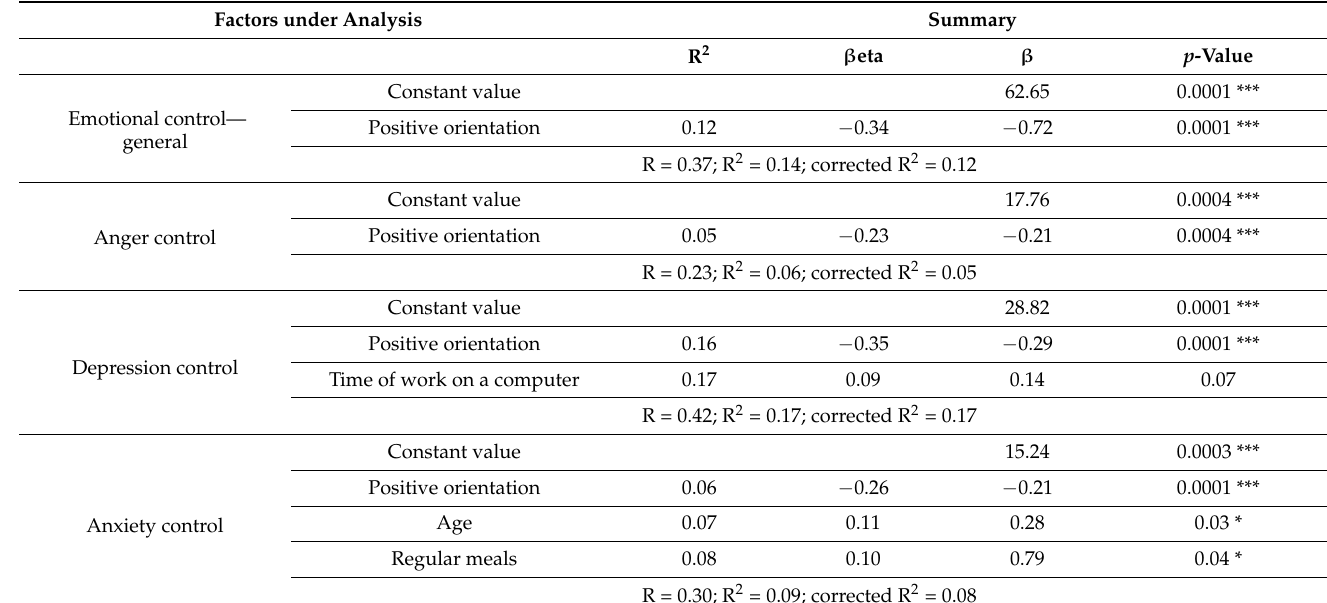
Table 4. Multiple regression results—predictors of emotional control—general, concerning anger, depression and anxiety in the Polish